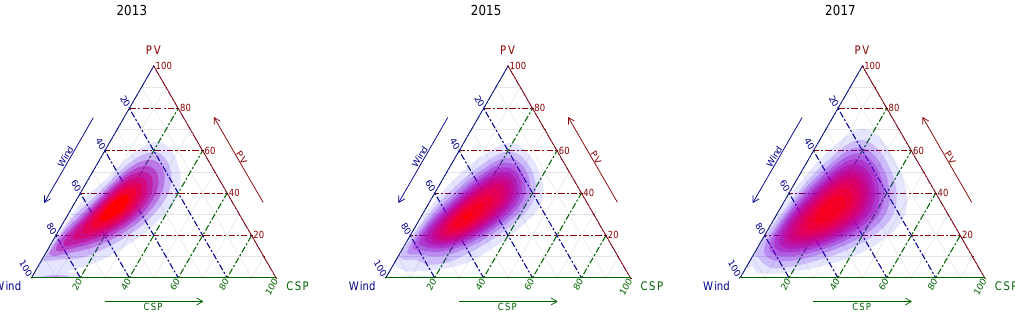
Figure 6. The contribution of variable renewable energies (VRES) to the total VRES generation for 2013, 2015 and 2017 represented by ternary plots. The units on each side are the percentages of each renewable energy with respect to the total VRES generation. Sources: authors based on the data from REE